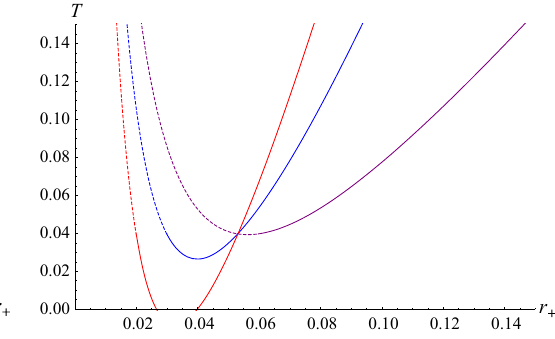
Fig. 6 Plots of the black hole temperature for the positive effective horizon curvature (left) and the zero one (right). Left panel: the blue, red, and green curves correspond to P = 0 . 5, 1 . 1353 ( P c ) , 2, respec- tively, at m = c = c 1 = c 2 = 1 and k = 0 . 1. Right panel: the